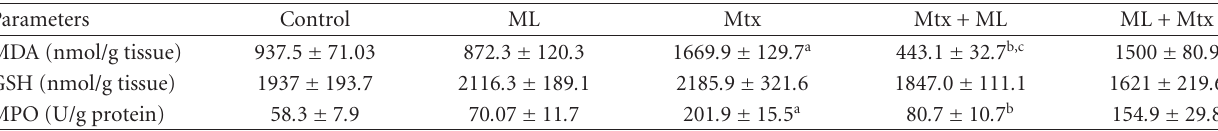
Table 1: The levels of biochemical parameters of all